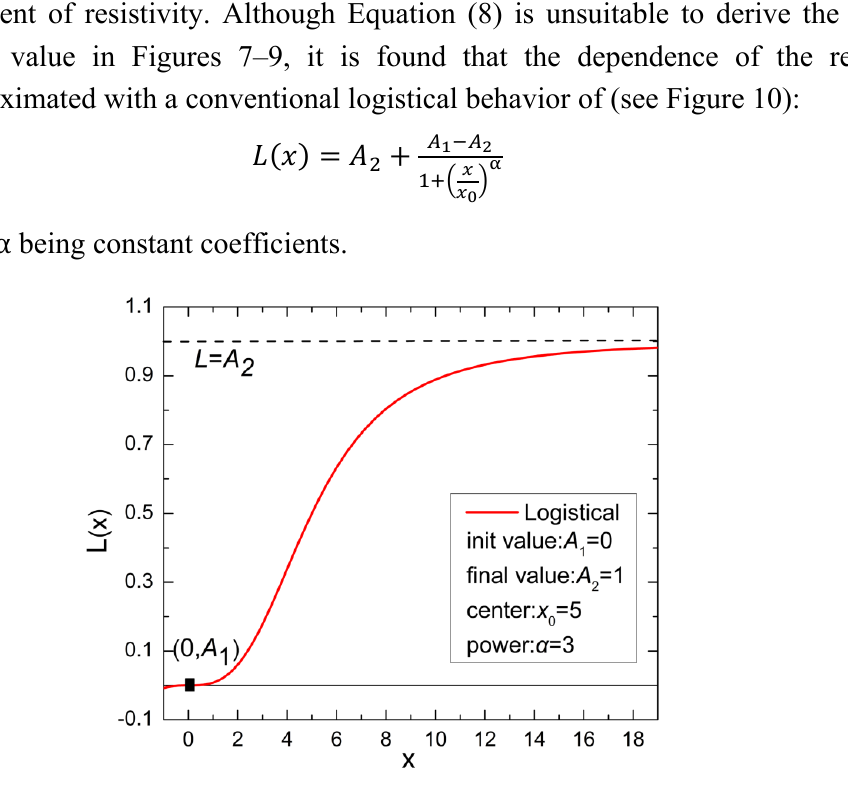
Figure 10. The simplified curve of the logistical fit function 𝐿(𝑥) . The parameters have been defined as constant values in the